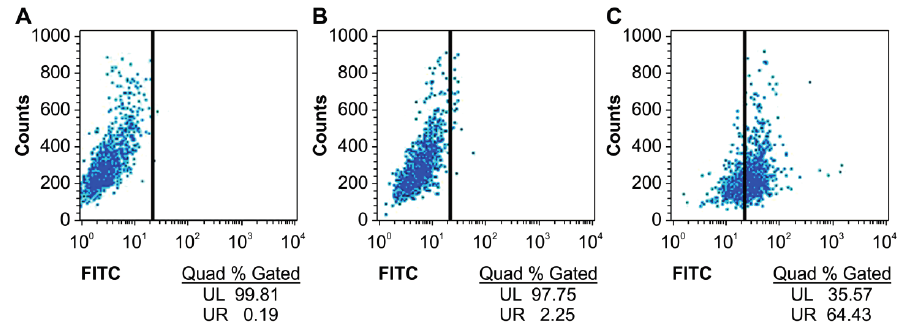
Figure 2. Affinity of anti-TLR4 antibody Fab to TLR4 measured by flow cytometry. ( A ) Blank; ( B ) Without Fab antibody treatment group; ( C ) Fab antibody treatment group.UL: upper left; UR: upper right; FITC: fluorescein isothiocyanate.